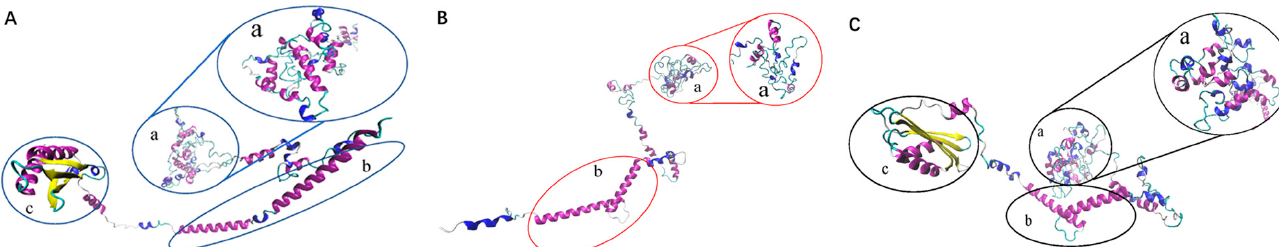
Figure 7. Three-dimensional structure of bHLH protein. a, b and c represent same protein regions in three different protein structures, respectively. ( A ) Three-dimensional structure of the protein of LcbHLH 24; ( B ) Three-dimensional structure of the protein of LcbHLH 72; ( C ) Three-dimensional structure of the protein of At ICE1.